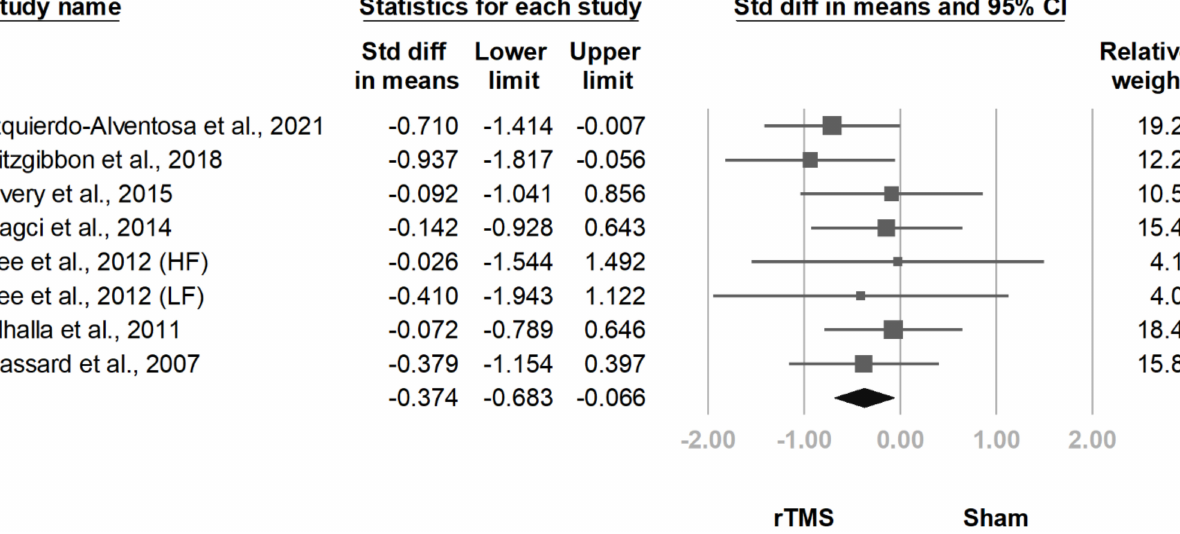
Figure 16. Forest plot of standardized mean differences in Beck Depression Inventory at follow-up at 2 weeks to 1 month after last treatment session. Squares indicate effect sizes of individual studies, lines indicate 95% CI, and diamond indicates the summarized effect